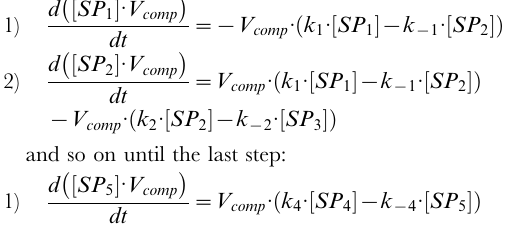
Figure S3 Trigonal collapsed cycle with bottom apex. A. Thermodynamic cycle relating the energy of the cyclization reaction in solution with the energy of the same reaction in the enzyme active site. E N R and E N P are the enzyme:reactant and the enzyme:product complexes, respectively. B. Intermediate step leading to the collapsed cycle shown in panel C. C. Collapsed cycle in which the same energy quantity ( D G 0 R R Pbound ) has been subtracted from the horizontal branches of the cycle shown in panel A. The cycle gives origin to the following algebraic relationship: